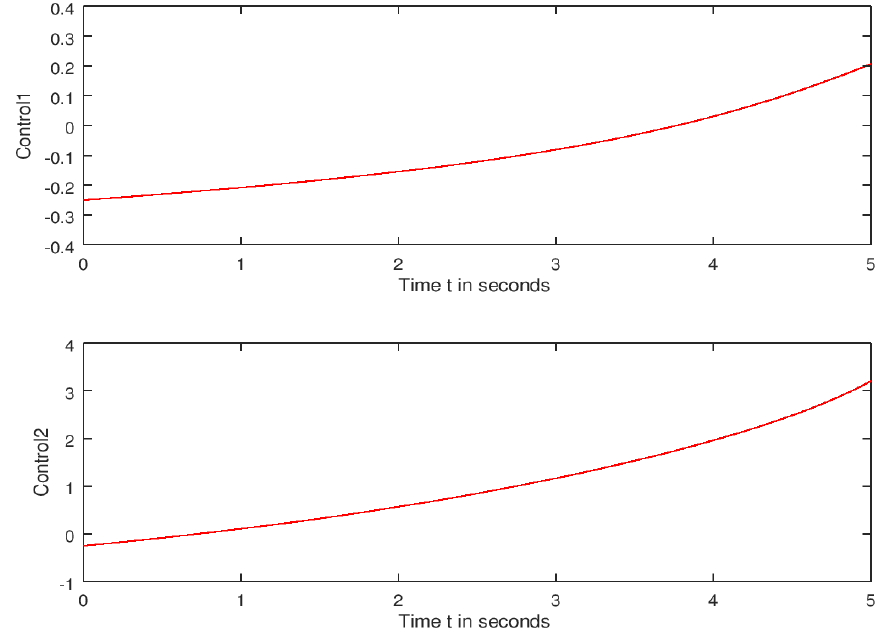
Figure 14. Feasible last four costate trajectories.